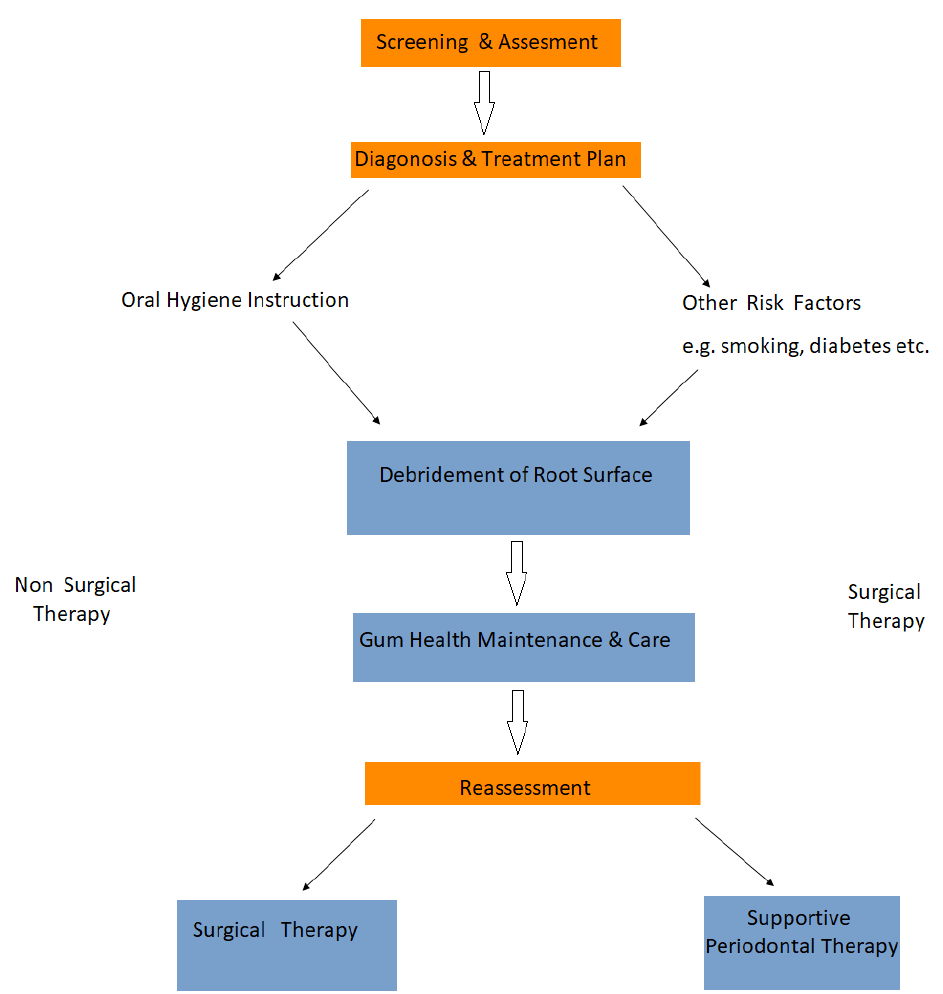
Figure 3. Representation of distinct stages of periodontal assessment. The examining and monitoring part including assessment and diagnosis / treatment plant are denoted in orange whereas the surgical and non-surgical parts included in maintenance and cares are denoted in blue.